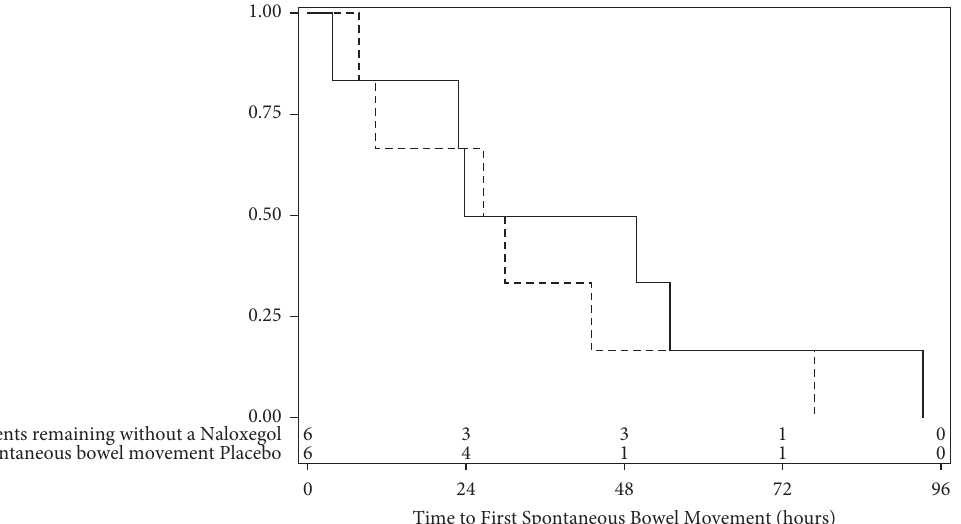
Figure 2: Time to first spontaneous bowel movement from the time of enrolment. The Kaplan–Meier curve for the time to the first spontaneous bowel movement occurrence between the naloxegol and placebo groups during the ICU stay from the time of enrolment (log rank P value � 0.56). The naloxegol and placebo lines at the bottom of the figure refer to the patients still receiving study drug. Table 3: Clinical outcomes A